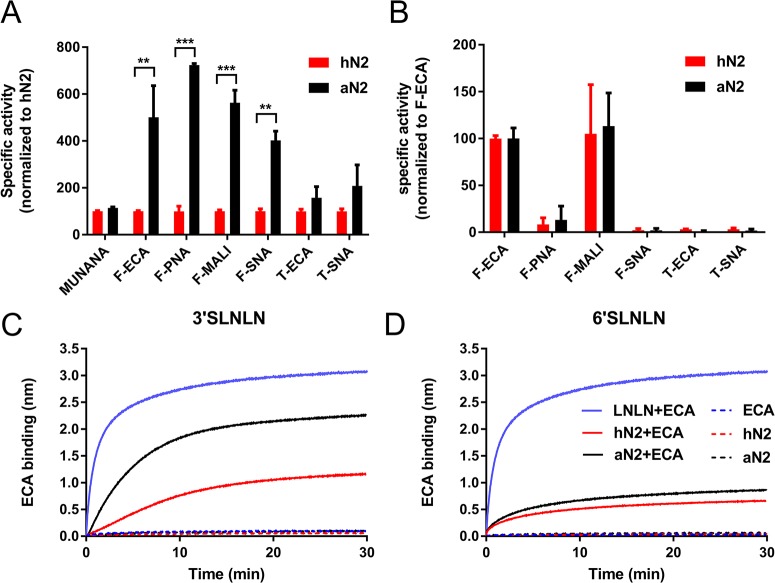
Enzymatic activity of N2 proteins assayed using different substrates.(A) Specific activity of hN2 and aN2 was determined by MUNANA assay and ELLA using different glycoprotein-lectin combinations (Fetuin-ECA, Fetuin-PNA, Fetuin-MAL I, Fetuin-SNA, Transferrin-ECA and Transferrin-SNA) and normalized to the specific activity of hN2 for MUNANA and each glycoprotein-lectin combination. (B) Specific activity of hN2 and aN2 is graphed normalized to the specific activity as determined for each protein by the Fetuin-ECA combination. Mean values and standard deviations from two independent experiments performed in triplicate are shown. Stars depict P values calculated using an unpaired two-tailed Student t test (**, P<0.01; ***, P<0.001). (C and D) BLI kinetic assay of NA enzymatic activity. Streptavidin biosensors were coated with biotinylated synthetic glycans (3’SLNLN, 6’SLNLN or LNLN). Subsequently, the sensors were incubated in buffer containing 4 μg aN2 or hN2 in the absence or presence of 8 μg ECA or ECA alone. ECA binding to sensors coated with 3’SLNLN or 6’SLNLN is a measure for SIA cleavage from these receptors by NA. Experiments were independently performed three times. Representative experiments are shown.